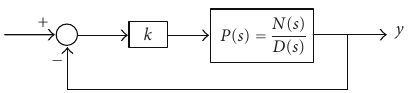
Figure 1: Standard closed-loop